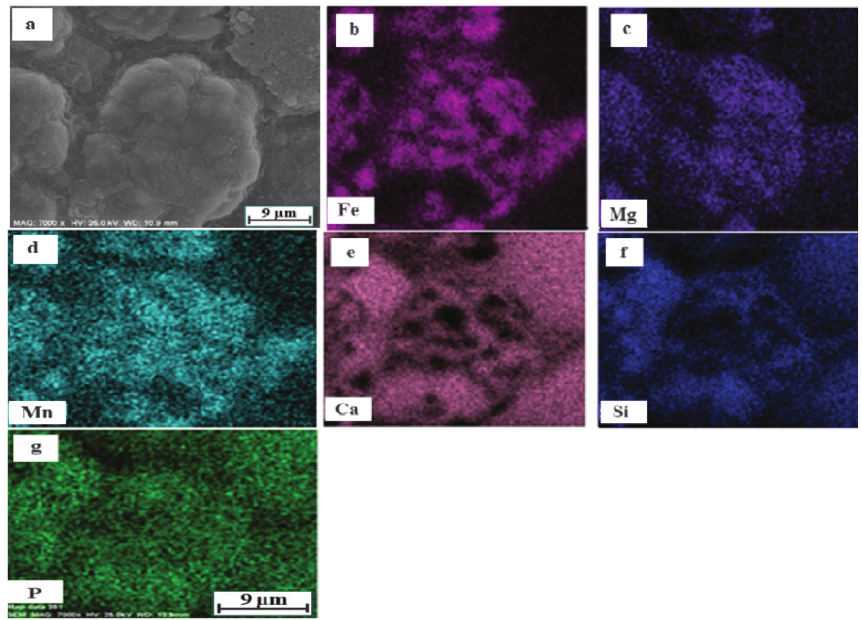
Figure 6: SEM-mapping photos result in the first deslagging of 2# heat: (a) SEM image, (b) to (g)